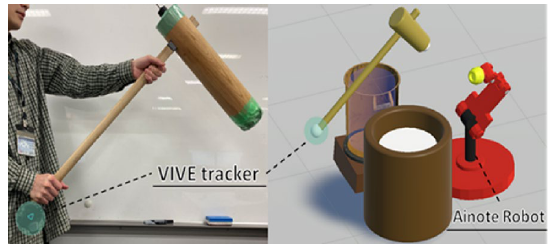
Fig. 2 Virtual reality environment system overview